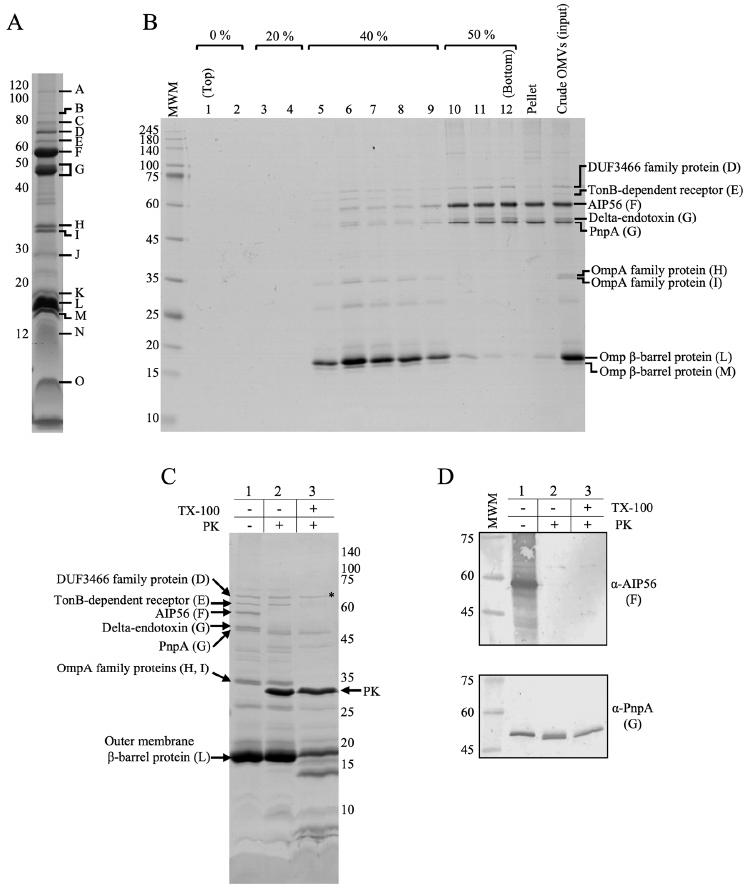
Figure 2. Phdp OMVs protein profile. ( A ) Coomassie Blue-stained SDS-PAGE gel of crude OMVs from Phdp strain MT1415. The gel was loaded with 8 µ L of crude OMVs, which correspond to 30 mL of a late exponential culture (OD 600nm of 0.9). The indicated bands correspond to the proteins identified by mass spectrometry (see Table 1). ( B ) The bulk of the T2SS-dependent proteins AIP56 and PnpA present in crude OMVs are not associated with the vesicles. Crude MT1415 OMVs were floated in a discontinuous Histodenz gradient, comprising 50, 40, 20, and 0% Histodenz solution, as indicated. Crude OMVs were loaded at the bottom and fractions were collected from top to bottom. ( C ) AIP56 and PnpA proteins that remain associated with OMVs after floating purification step are located on the outside of the vesicles. Fractions 5–7 of floated OMVs were pooled, either left untreated or treated with proteinase K (PK) in the presence or absence of Triton X-100 (TX-100), and subjected to 15% SDS-PAGE followed by Coomassie staining. The asterisk indicates a protein that is intrinsically resistant to PK digestion. ( D ) Immunoblotting analysis of the samples from panel C using anti-AIP56 and anti-PnpA antibodies. Letters between brackets in panels ( B – D ) correspond to the bands indicated in panel ( A ). Numbers at the left or right-side of gels/membranes indicate the position and mass of the molecular weight markers (MWM), in